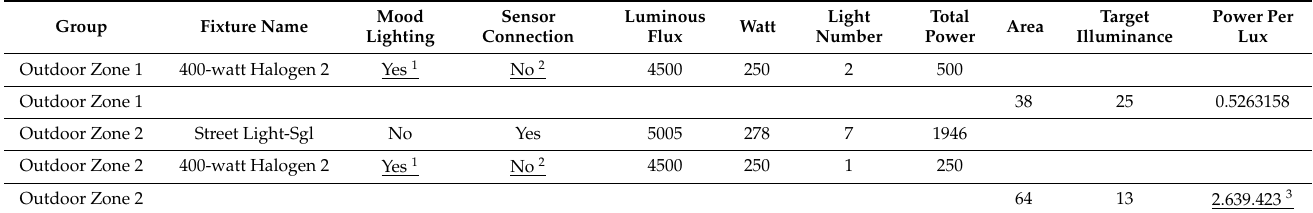
Table 7. Report generated by the